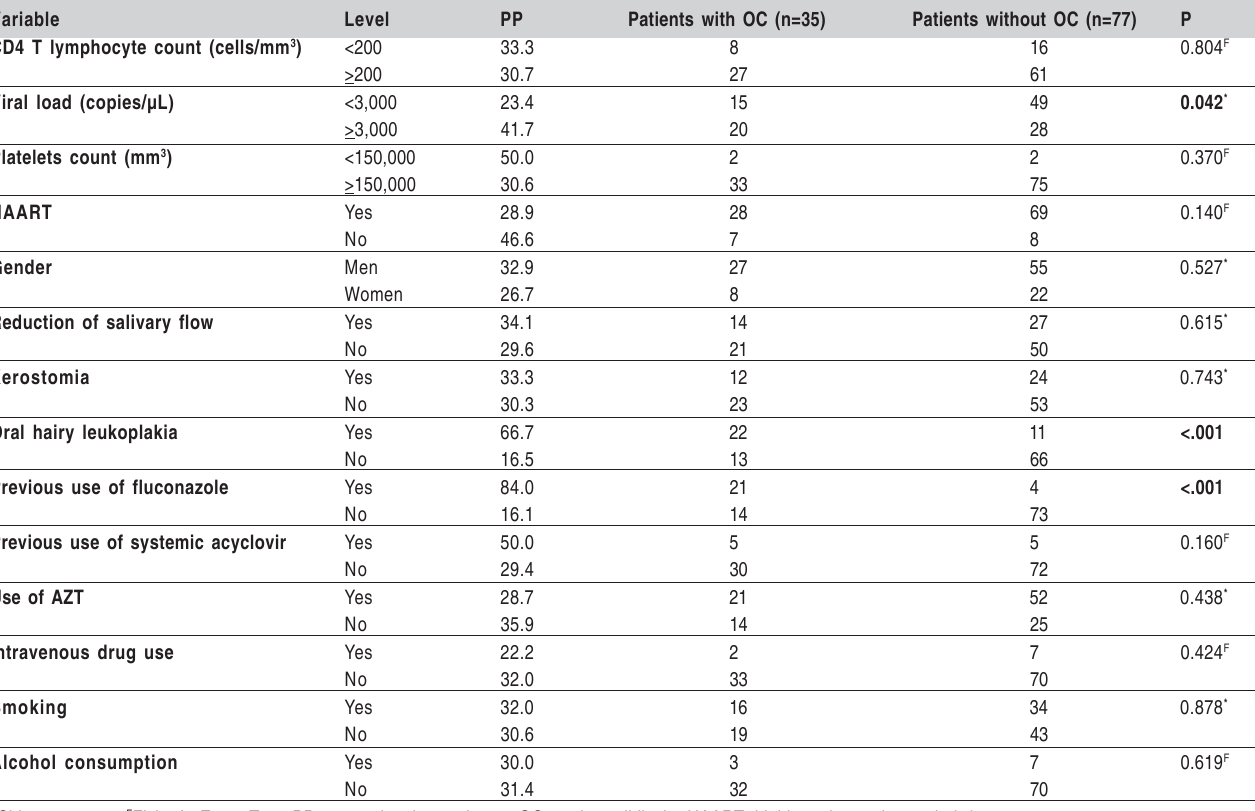
Table 1. Proportional prevalence and univariate analyze for oral candidiasis among 112 HIV/AIDS patients attended to at the CTR-DIP, Belo Horizonte, MG, Brazil, during 2002 to